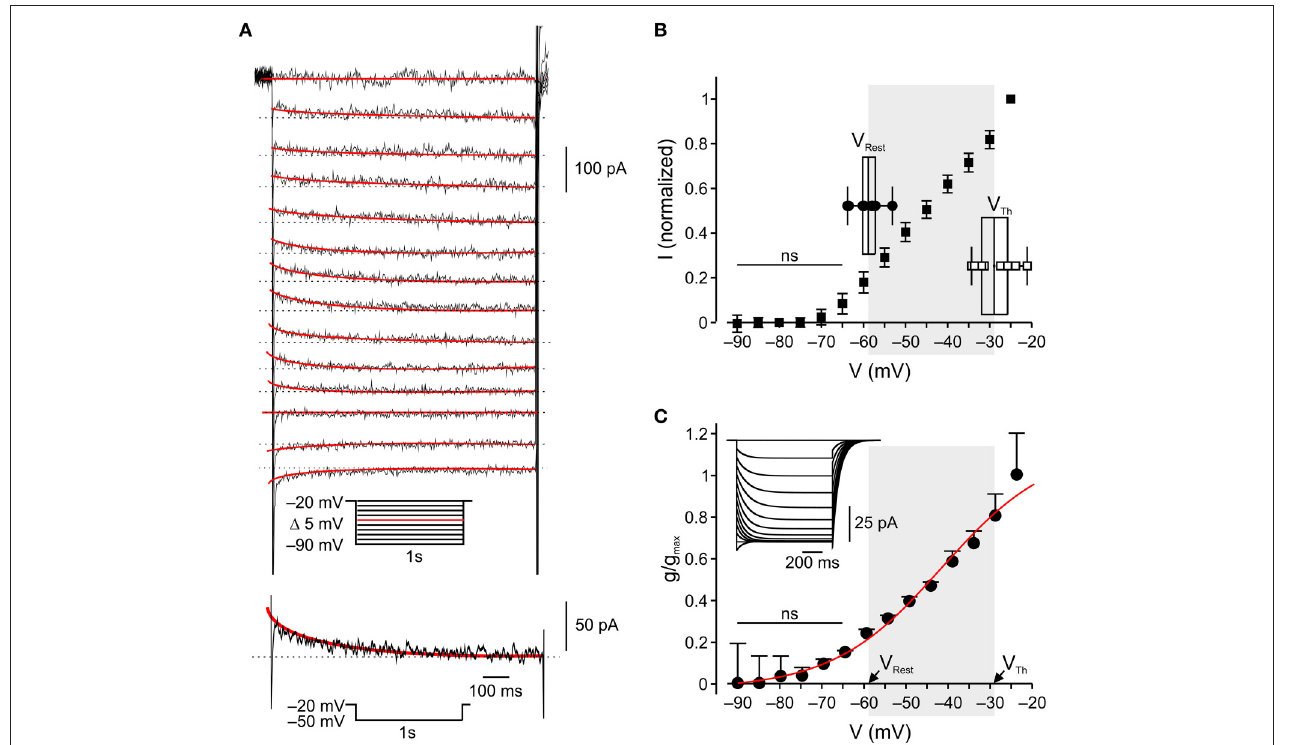
FIGURE 2 | In nociceptor-like DRG neurons I M is outward at resting-to-threshold potential range (A) . Upper , Typical voltage-clamp perforated patch recordings of I M from a nociceptor-like DRG neuron (see Methods, representative of 18/18 neurons). A family of currents was evoked by a series of 1s, 5mV hyperpolarizing voltage steps from a holding potential of − 20mV (voltage protocol is shown in inset ). The peak current response obtained by stepping to − 50mV is shown at the bottom. The I M relaxation was fitted with a bi-exponential line ( red ), which was extrapolated to the beginning of the voltage step. I M amplitudes were measured as the differences between the instantaneous peak currents at command onset and the steady-state currents just before command offset ( dotted line ). (B) Averaged leak-subtracted peak I-V characteristics of I M recorded from nociceptor-like DRG neurons ( n = 18), calculated as described in Methods. ns—not significant; one-way ANOVA comparison between the current values obtained at − 90mV (zero current level) to currents at other command voltages. Note, significant outward current at − 60mV. Insets show box charts and individual values of resting membrane potentials (V Rest , n = 10) and action potential thresholds (V Th , n = 9), obtained from current clamp perforated patch recordings (see Methods). The middle line of the box charts represents the mean; the box represents 25 ∼ 75% percentiles and caps delineate range within 1.5 interquartile range. The mean (inmV) is aligned to its values on the x-axis. The shadowed area indicates the range of membrane potentials between resting potential and threshold. (C) Mean ± SEM of I M activation curves ( g / g max ) fitted using the Boltzmann equation (see Methods) shows the onset of activation at − 60mV (ns—not significant; one-way ANOVA comparison between the conductance values obtained at − 90mV (zero conductance level) to conductances at other command voltages) and V 1 / 2 at − 42mV. The shadowed area indicates the range of membrane potentials between resting potential (mean, V Rest ) and threshold (mean, V Th ) taken from (B) , insets